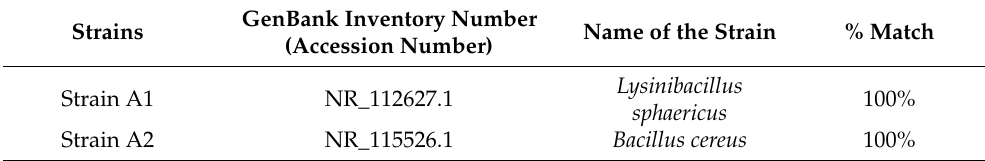
Table 1. The results of identification by analysis of the nucleotide sequence of the 16S rRNA gene.